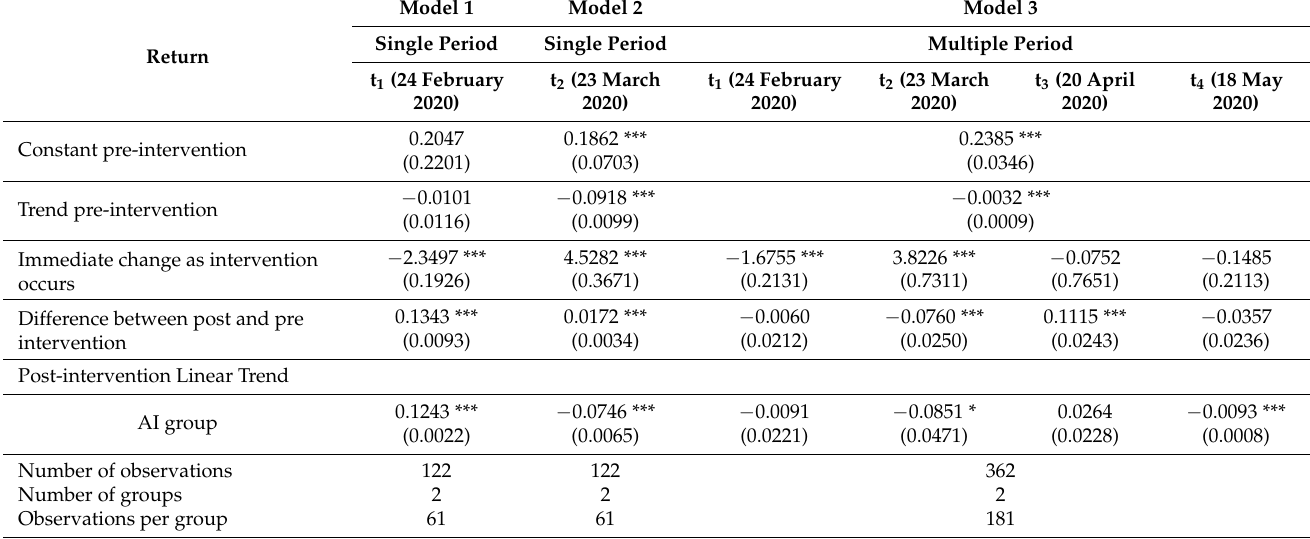
Table 4. Single-group analyses for the artificial intelligence market group with single and multiple periods.